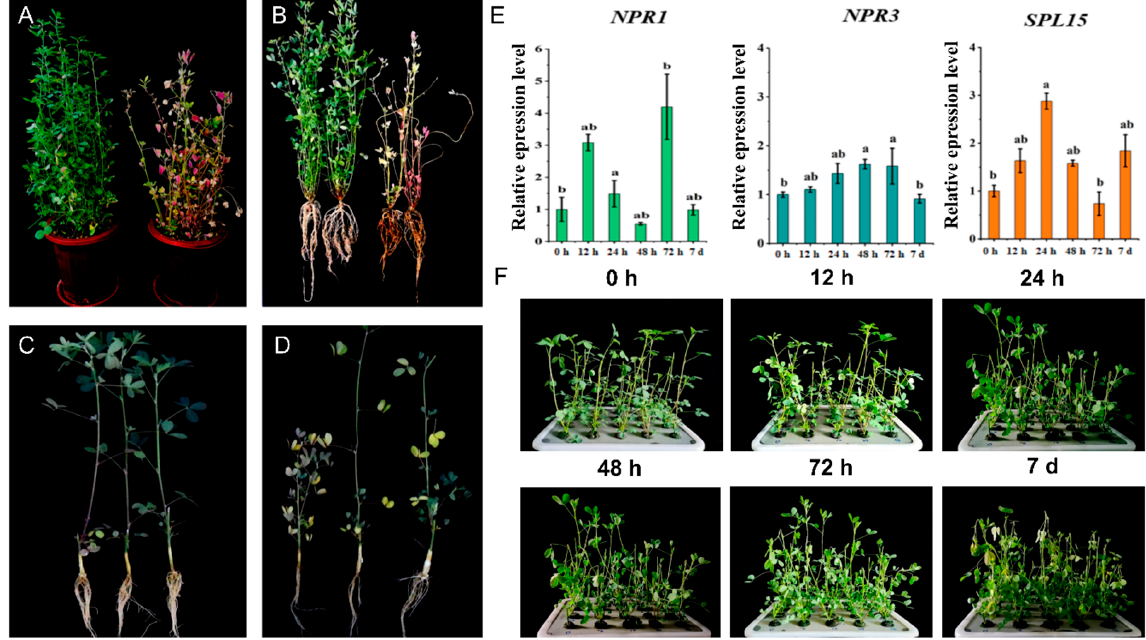
Figure 2. Screening of experimental plants and determination of the sampling time. ( A , B ) First screening of resistant (left) and susceptible plants (right). ( C , D ) Second screening of resistant ( C ) and susceptible plants ( D ). ( E ) The relative expression levels of the NPR1 , NPR3 , and SPL15 at 24 h, 48 h, 72 h, and 7 d. ( F ) Phenotype of the mixture of susceptible and resistant clonal lines at 24 h, 48 h, 72 h, and 7 d after inoculation. The different letters in ( E ) indicate significant differences in expression levels of NPR1 , NPR3, and SPL15 in inoculated group compared to those in uninoculated group ( p < 0.05).